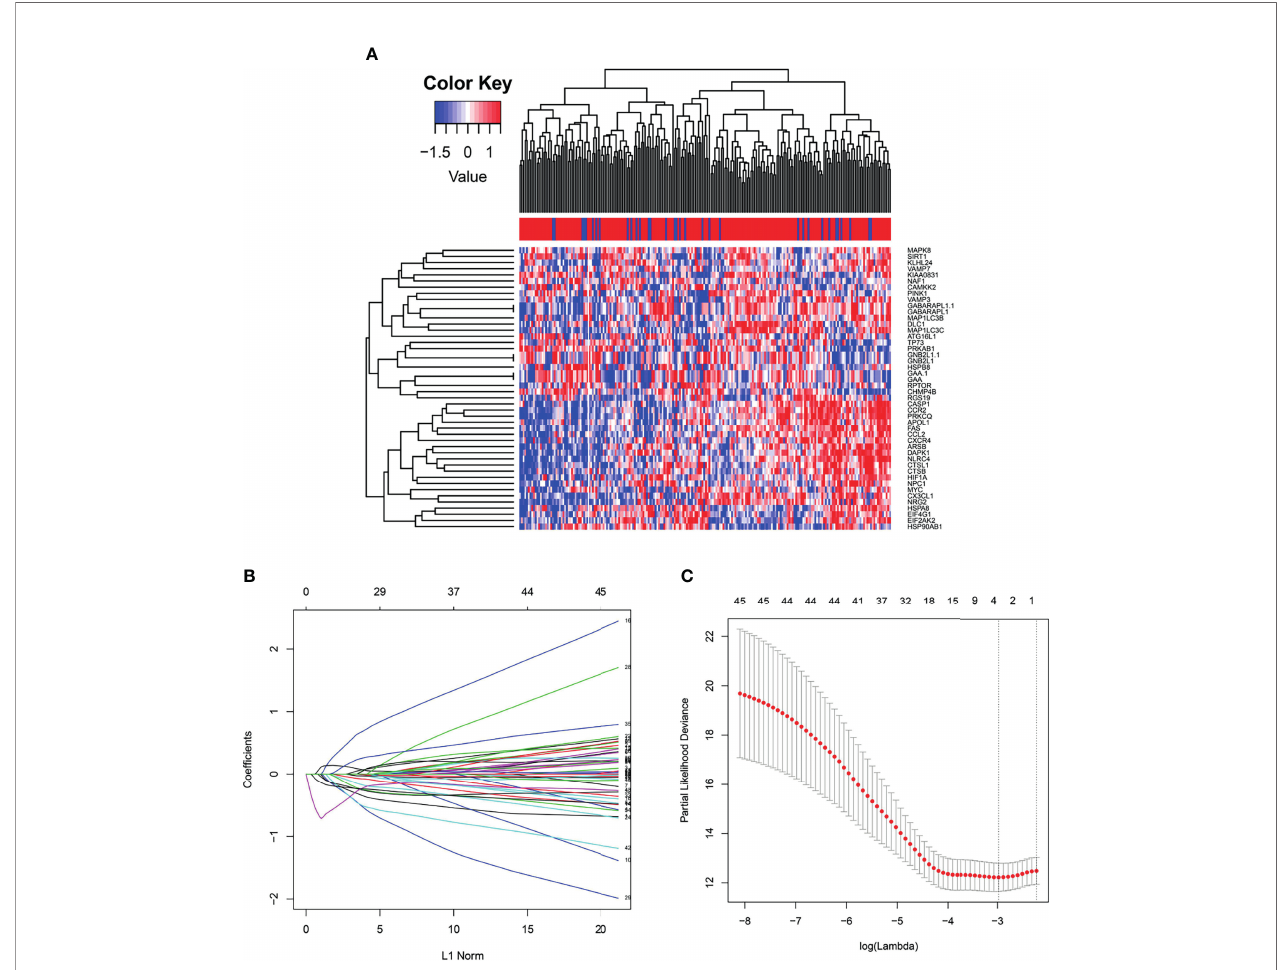
FIGURE 2 | (A) The heat map demonstrates forty-six differentially expressed mRNA in breast cancer among early relapse and long-term survival group both in training cohort; (B) LASSO coef fi cient pro fi les of the 4 early relapse-associated mRNA. A vertical line is drawn at the value chosen by 10-fold cross-validation; (C) X-tile analysis of the 4 selected